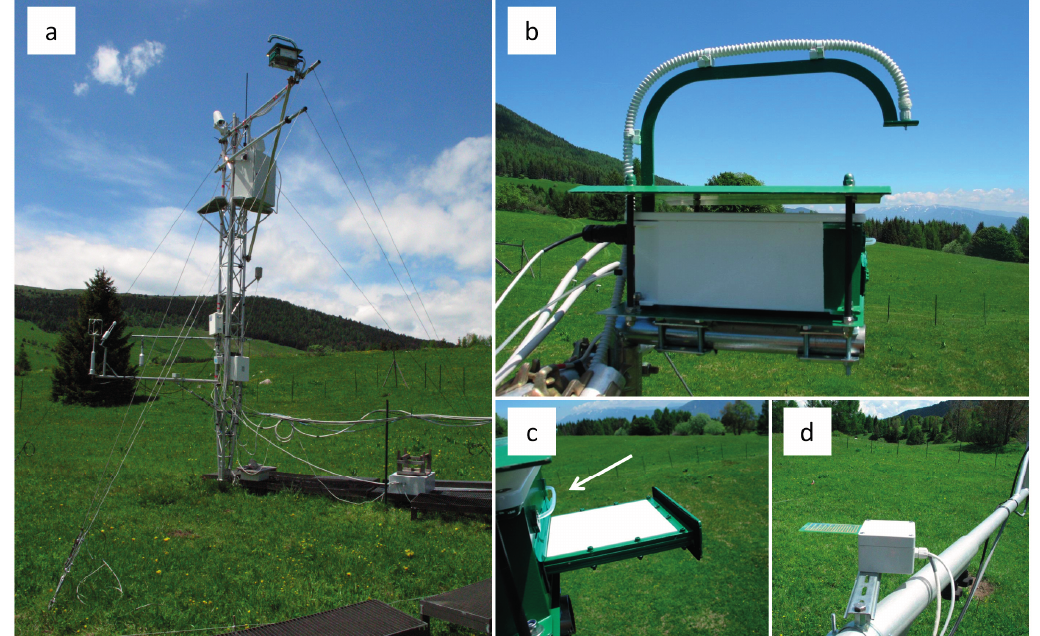
Figure 3. Viote del Monte Bondone research site: ( a ) Eddy Covariance tower equipped with the ASD WhiteRef hyperspectral system; ( b ) WhiteRef box; ( c ) white reference panel